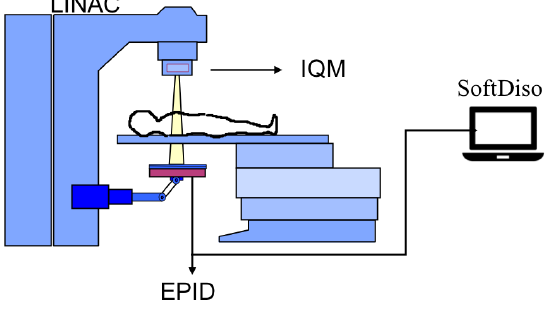
Figure 1. A scheme of measurement setup is displayed.